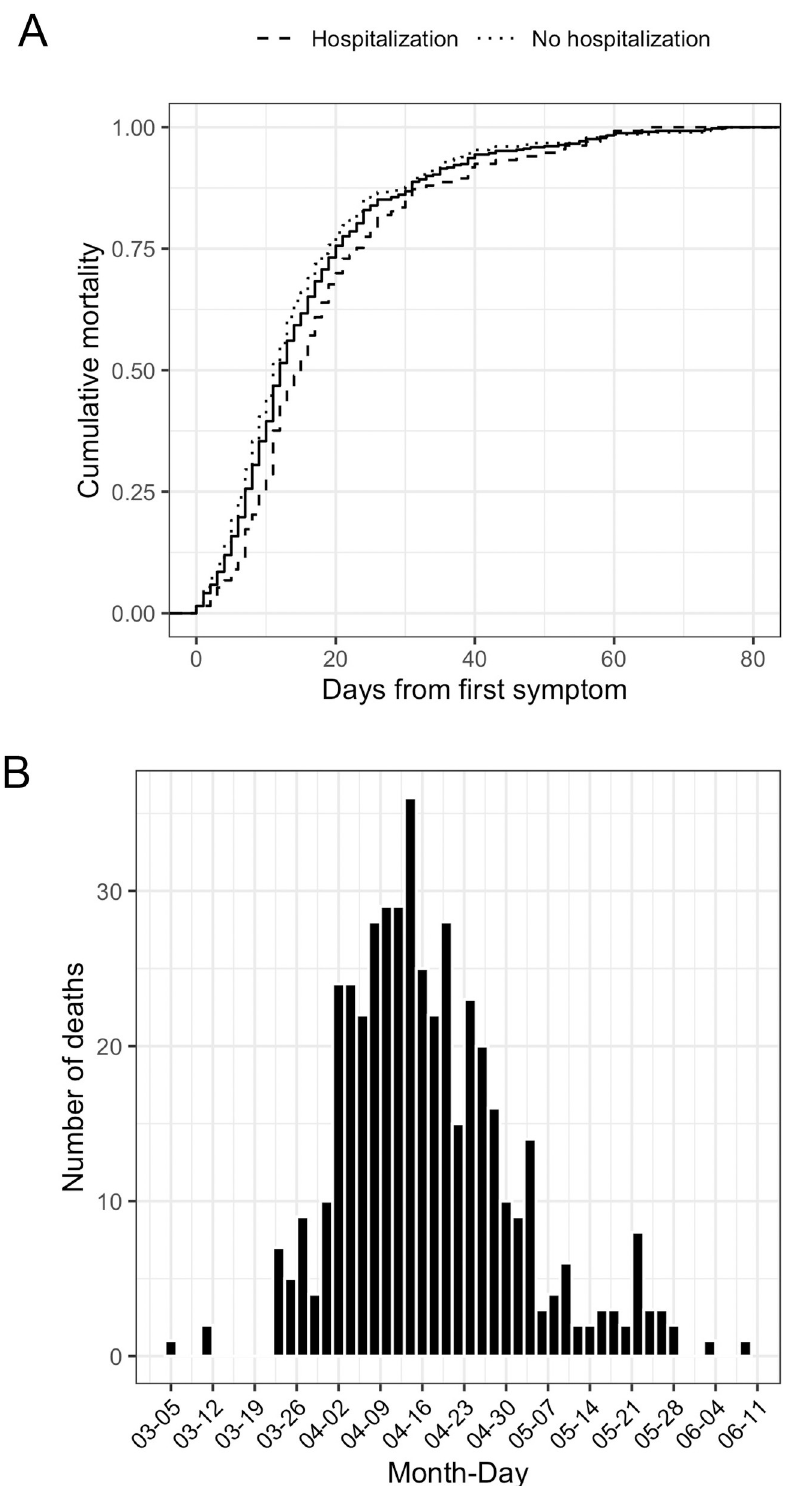
Fig 2. Mortality in the cohort. Legend: Panel A- Cumulative mortality rate. The p-value corresponds to the Kolmogorov-Smirnov test between the empirical cumulative distributions of survival days of hospitalized and non- hospitalized patients. Panel B- Date of